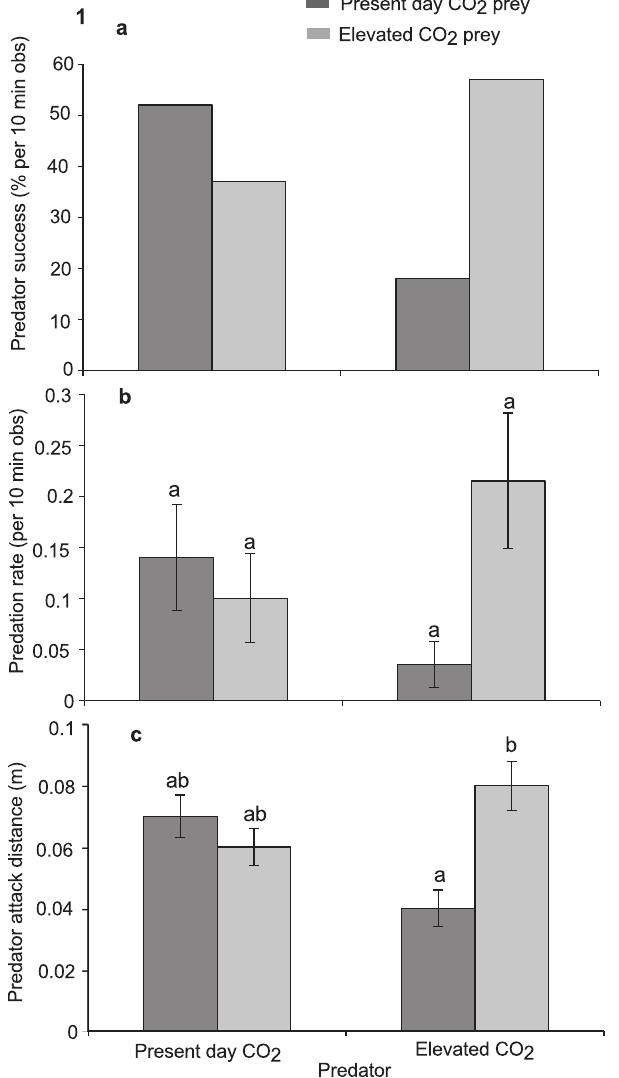
Figure 1. Effects of elevated CO 2 on predator attack perfor- mance. Comparison of the effects of elevated CO 2 (440, 880 m atm) on interactions between a predator ( Pseudochromis fuscus ) and prey ( Pomacentrus amboinensis ) on 3 performance variables of the predator: (a) predator success (b) predation rate and (c) predator attack distance. (a) N=21, 16, 16, 21, (b) N=21, 16, 16, 21 and (c) N=17, 15, 12, 16 (left to right). Errors are standard errors. Letters above bars represent Tukey’s HSD groupings of means. doi:10.1371/journal.pone.0058520.g001 PLOS ONE |